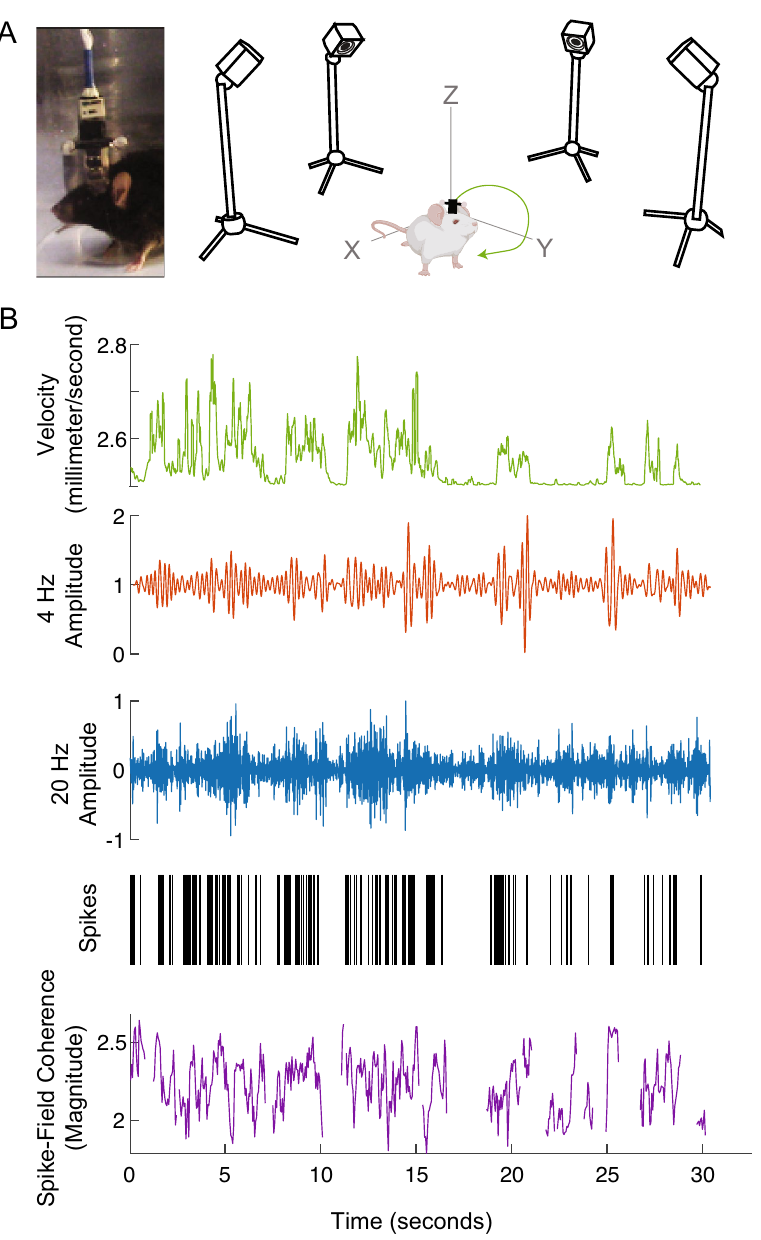
Figure 4. Striatal dynamics change with movement. ( A ) We tracked head movement using infrared-reflective spheres and an array of four cameras (OptiTrack). ( B ) We found that while animals moved, 4 Hz filtered (red) and 20 Hz filtered (blue) local field potentials (LFPs) were dynamic, as was the spike rate of medium spiny neurons (MSN; black) and 4 Hz spike-field coherence (purple; note that this value sometimes became indeterminate). Data from one